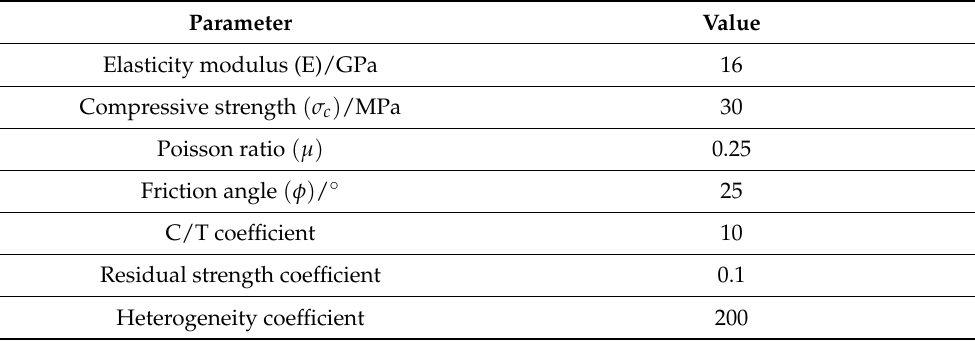
Figure 7. Numerical models and boundary conditions of surrounding rock with three kinds of dip angle joints (0°, 30° and 45°): ( a ) Model B0; ( b ) Model B30; ( c ) Model B45. Table 2. Physical and mechanical parameters of joint material.